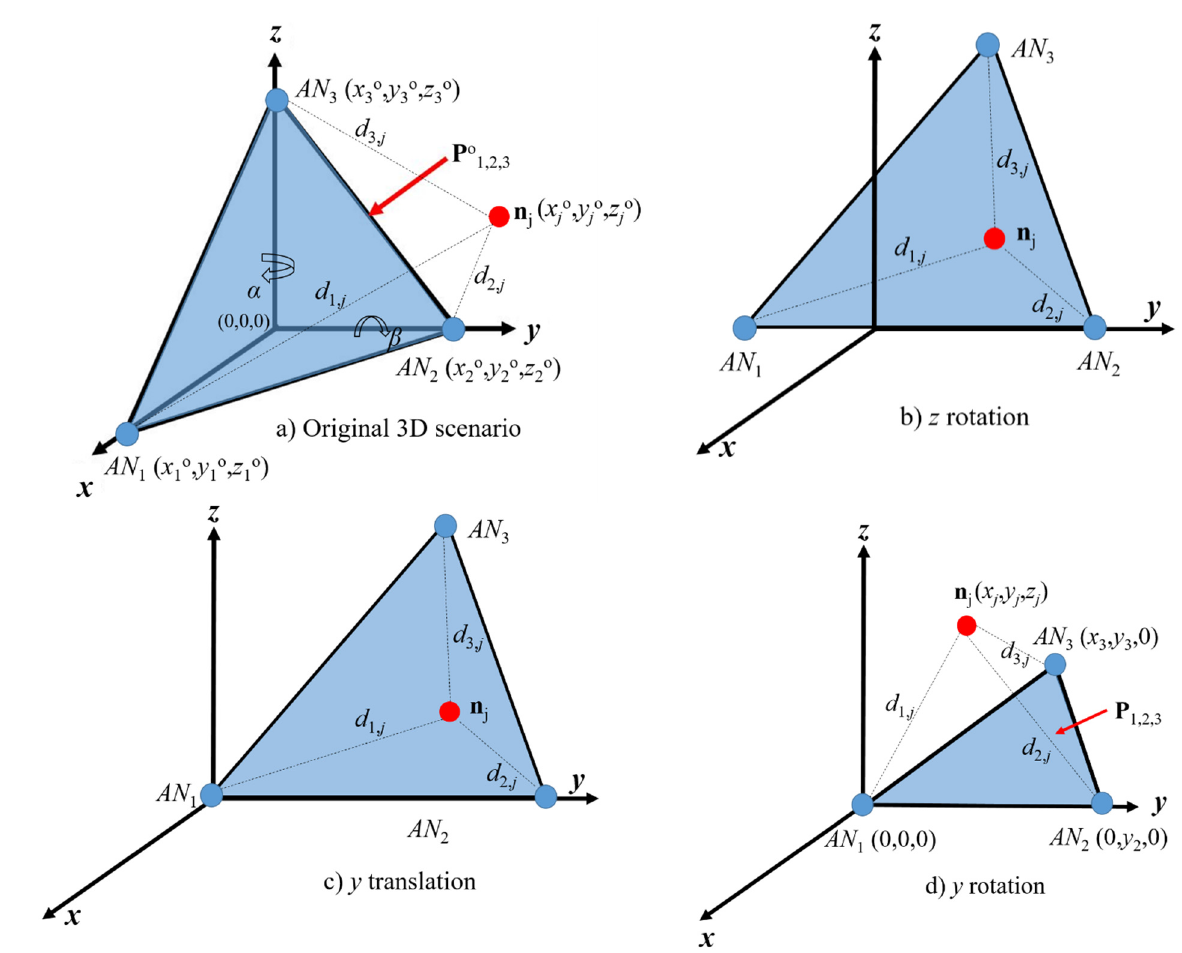
Figure 1. ( a ) Original 3D network scenario with three ANs. ( b ) Rotated reference plane with respect to the z -axis by angle α . ( c ) Translated reference plane. ( d ) Rotated reference plane with respect to the y -axis by angle β .